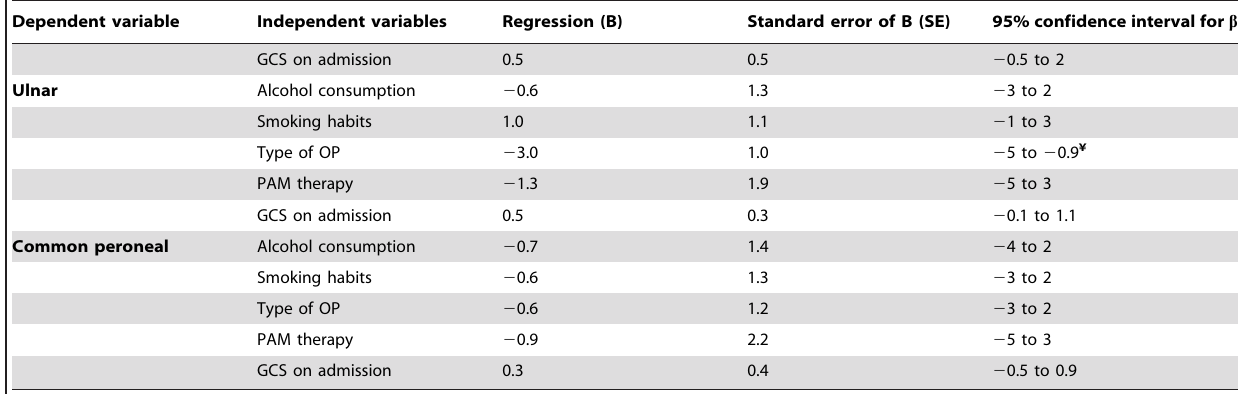
Dependent variable Independent variables Regression